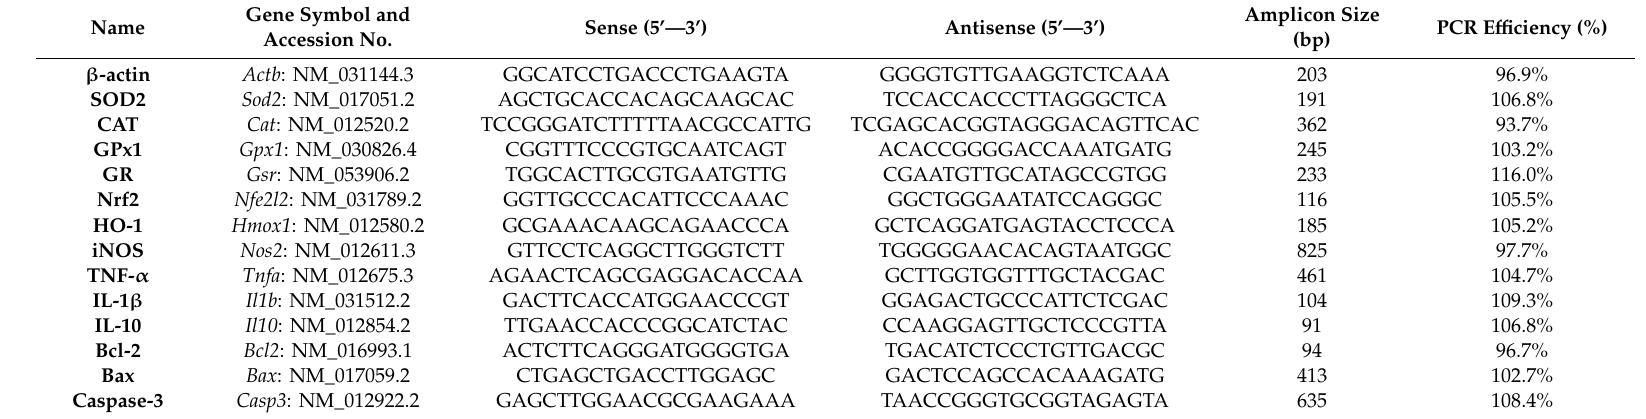
Table 1. Details of genes symbol, accession number, primer sequences, amplicon size and PCR e ffi ciency (%)* analyzed in Real-Time